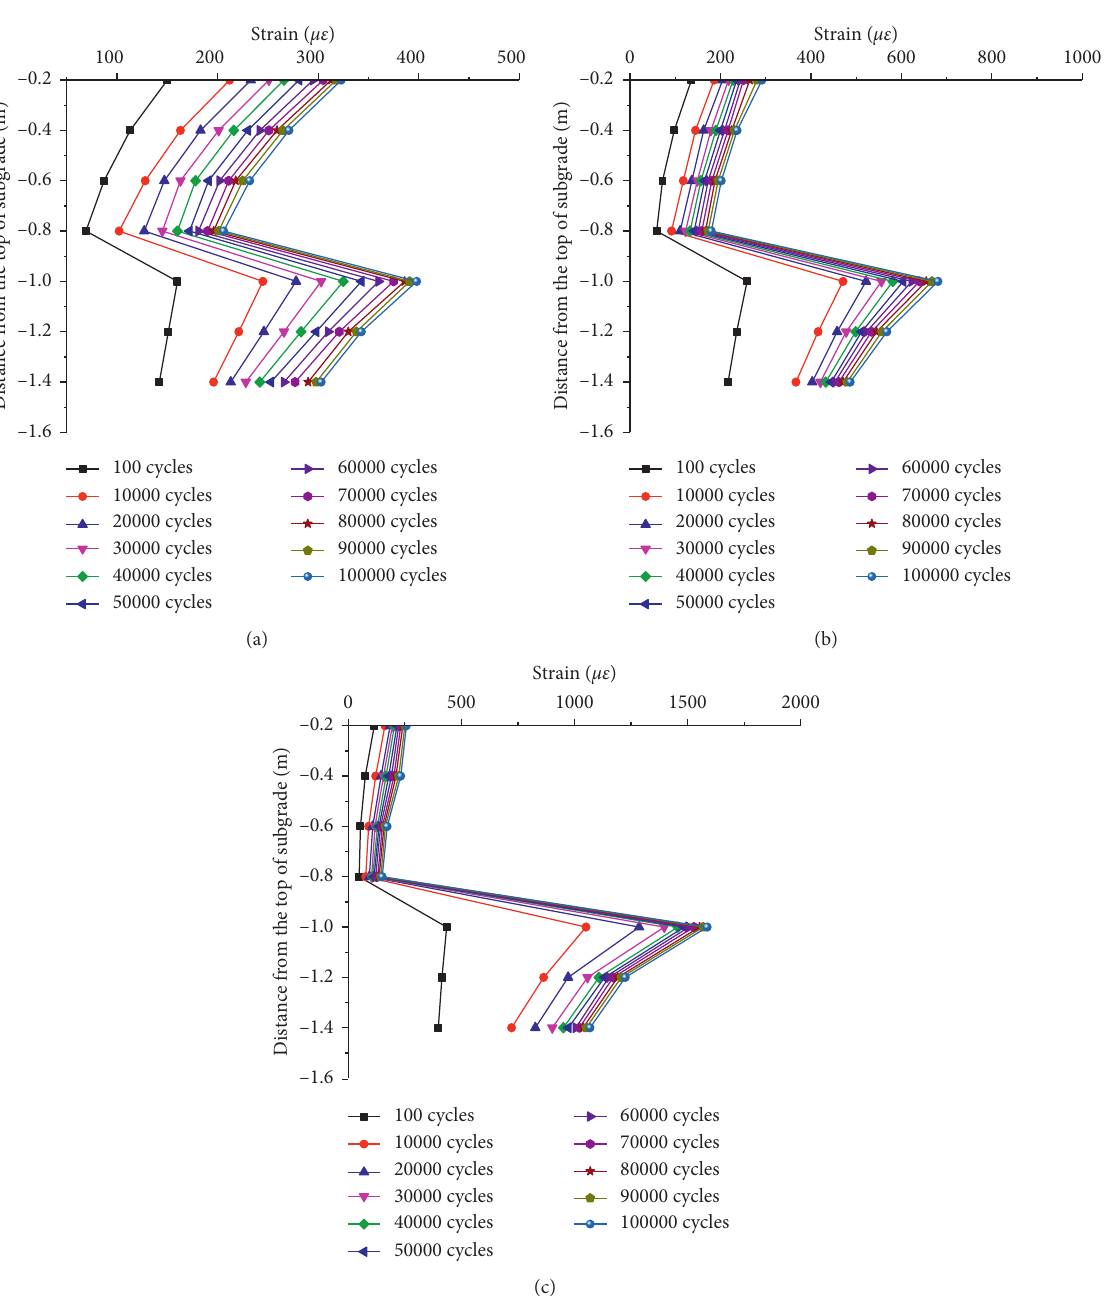
Figure 5: The relationships between strains and depths of each structural layer under different loading cycles. (a) The moisture content of the foundation was 18%. (b) The moisture content of the foundation was 23%. (c) The moisture content of the foundation was